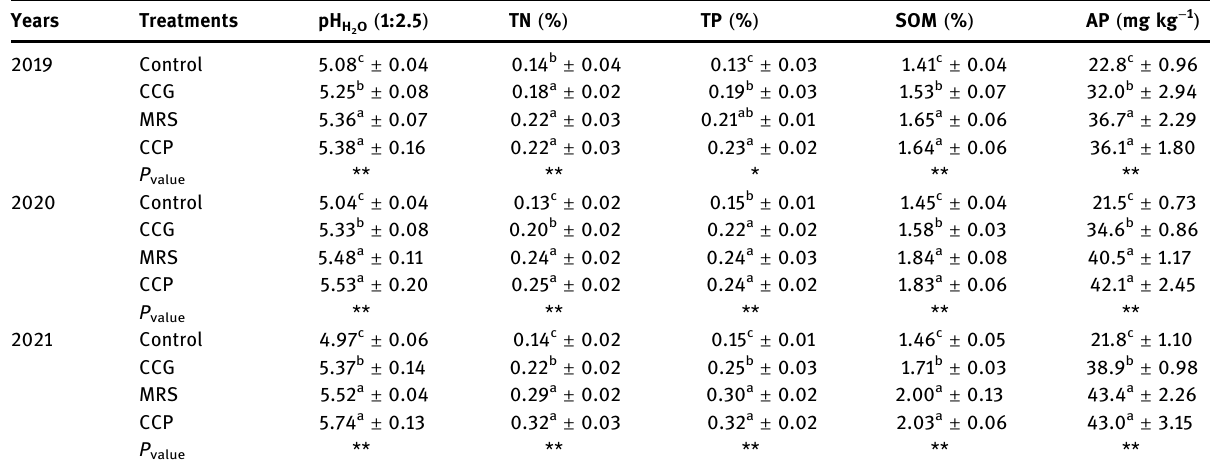
The di ff erent letters indicate the signi fi cant di ff erences among treatments at P < 0.05 ( * ) and P < 0.01 ( ** ) . CCG — cover crop by grass; MRS — mulching with rice straw; CCP — cover crop by pinto peanut.